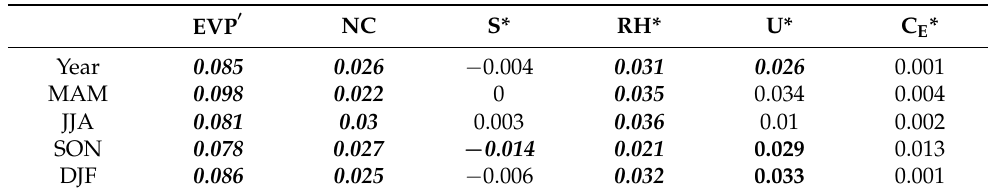
Figure 2. Time series of annual mean evaporation anomalies (EVP (cid:4593) ; black solid curve; unit: mm/d) over the tropical Indian Ocean, linear trend (EVP (cid:4593) _Trend; red solid curve; unit: mm/d/year) and interdecadal variation (EVP (cid:4593) _IDV; blue bars; unit: mm/d) of annual mean evaporation anomalies over the tropical Indian Ocean. Table 1. The trends of annual and seasonal mean evaporation anomalies and the decomposition terms. Unit: mm/d/decade .